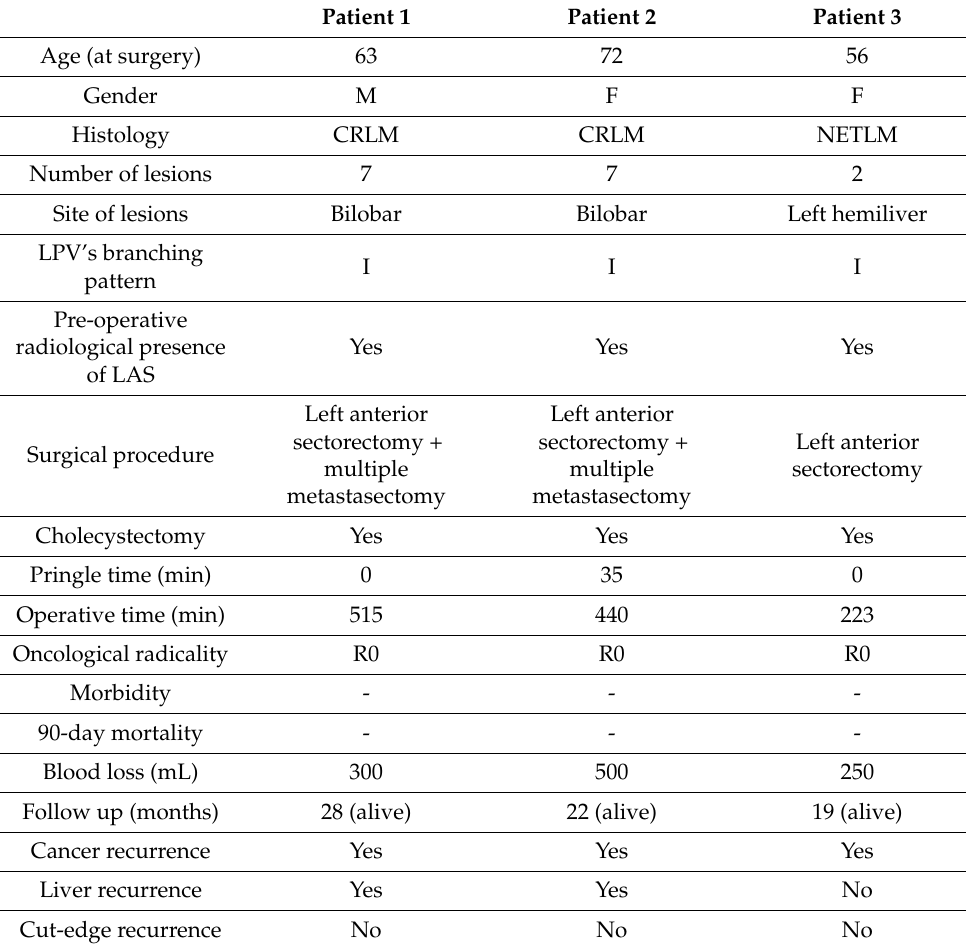
Table 1. Patients’ characteristics and post-operative